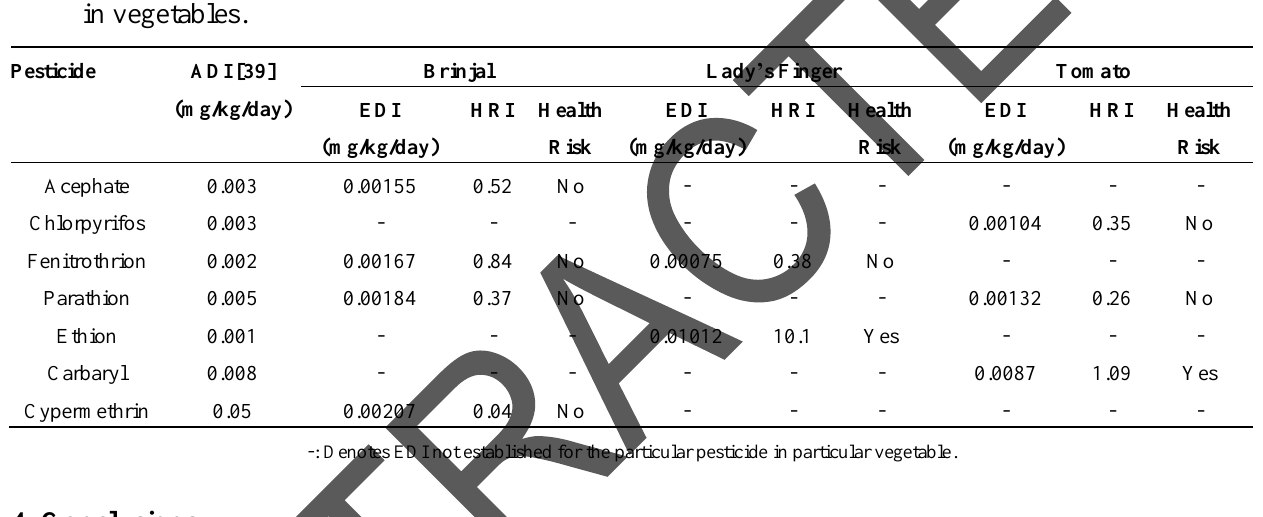
-: Denotes EDI not established for the particular pesticide in particular